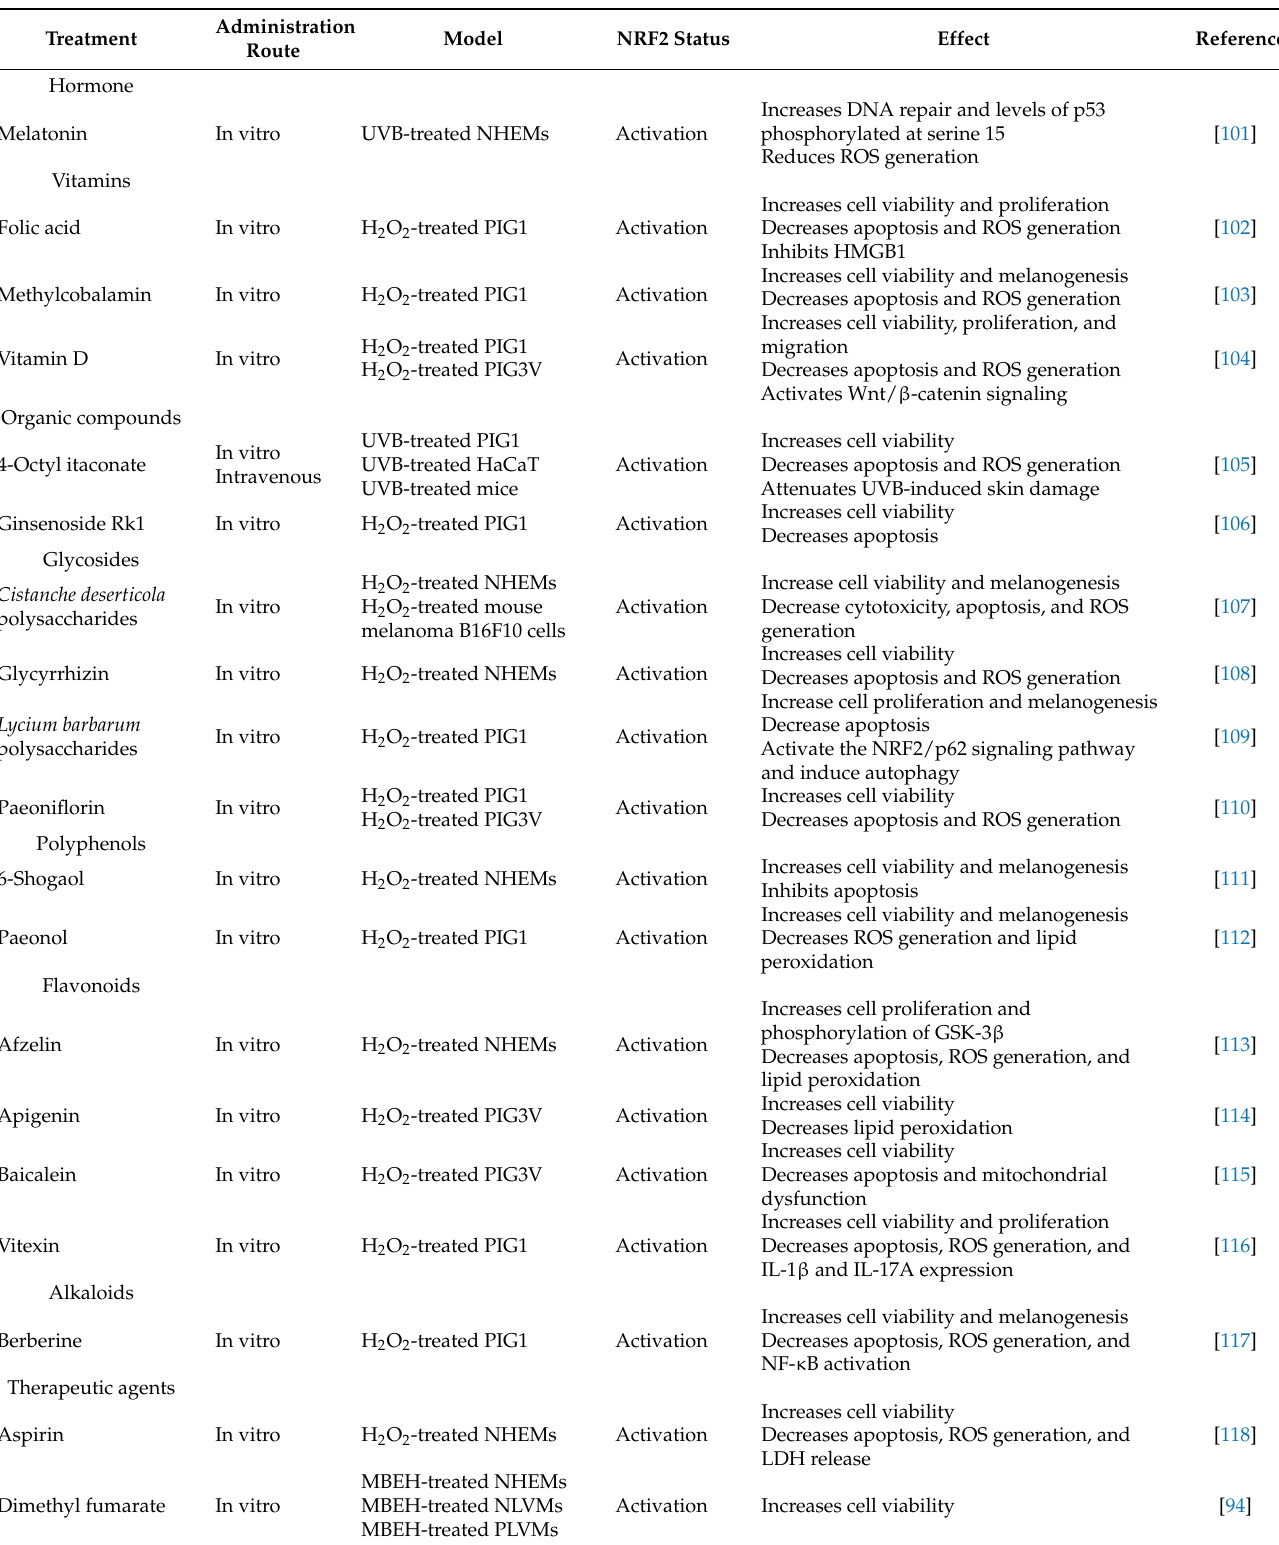
Table 1. NRF2-targeted therapy in